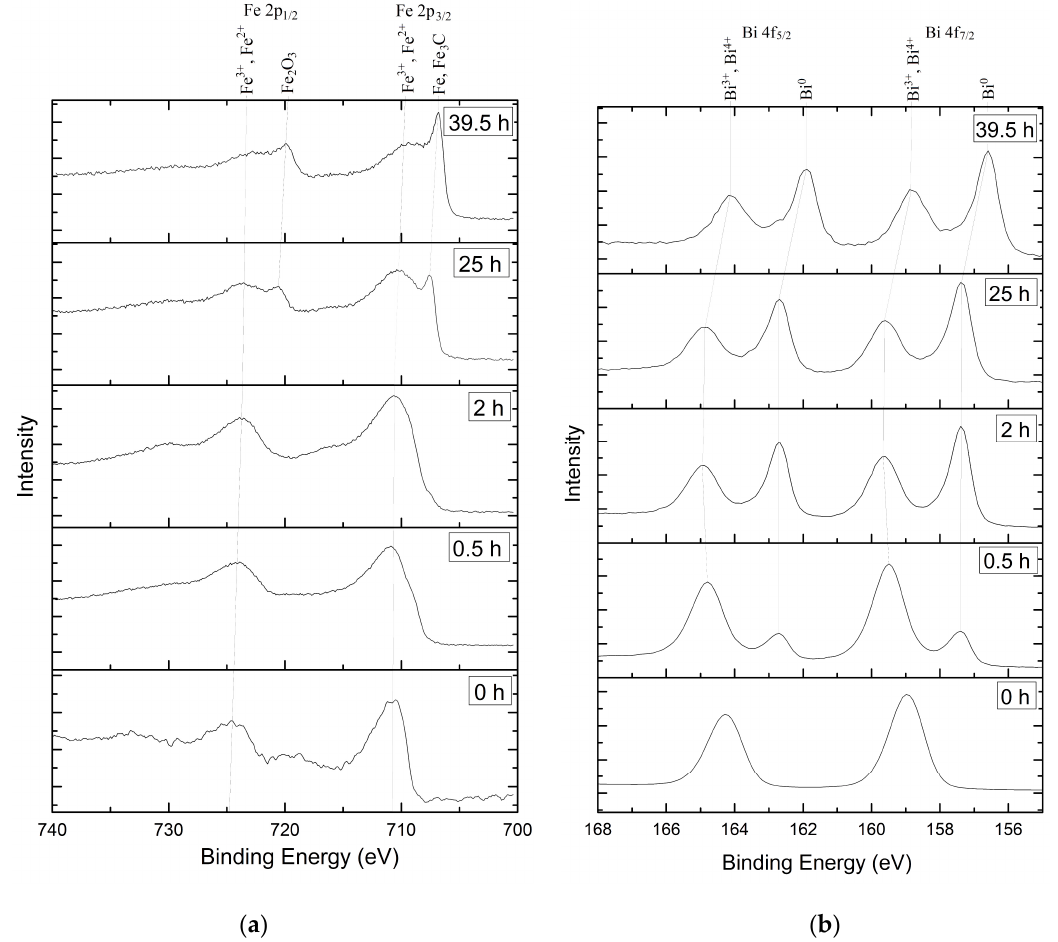
Figure 4. XPS element spectra of the etched surface: ( a ) Fe2p; ( b ) Bi4f.